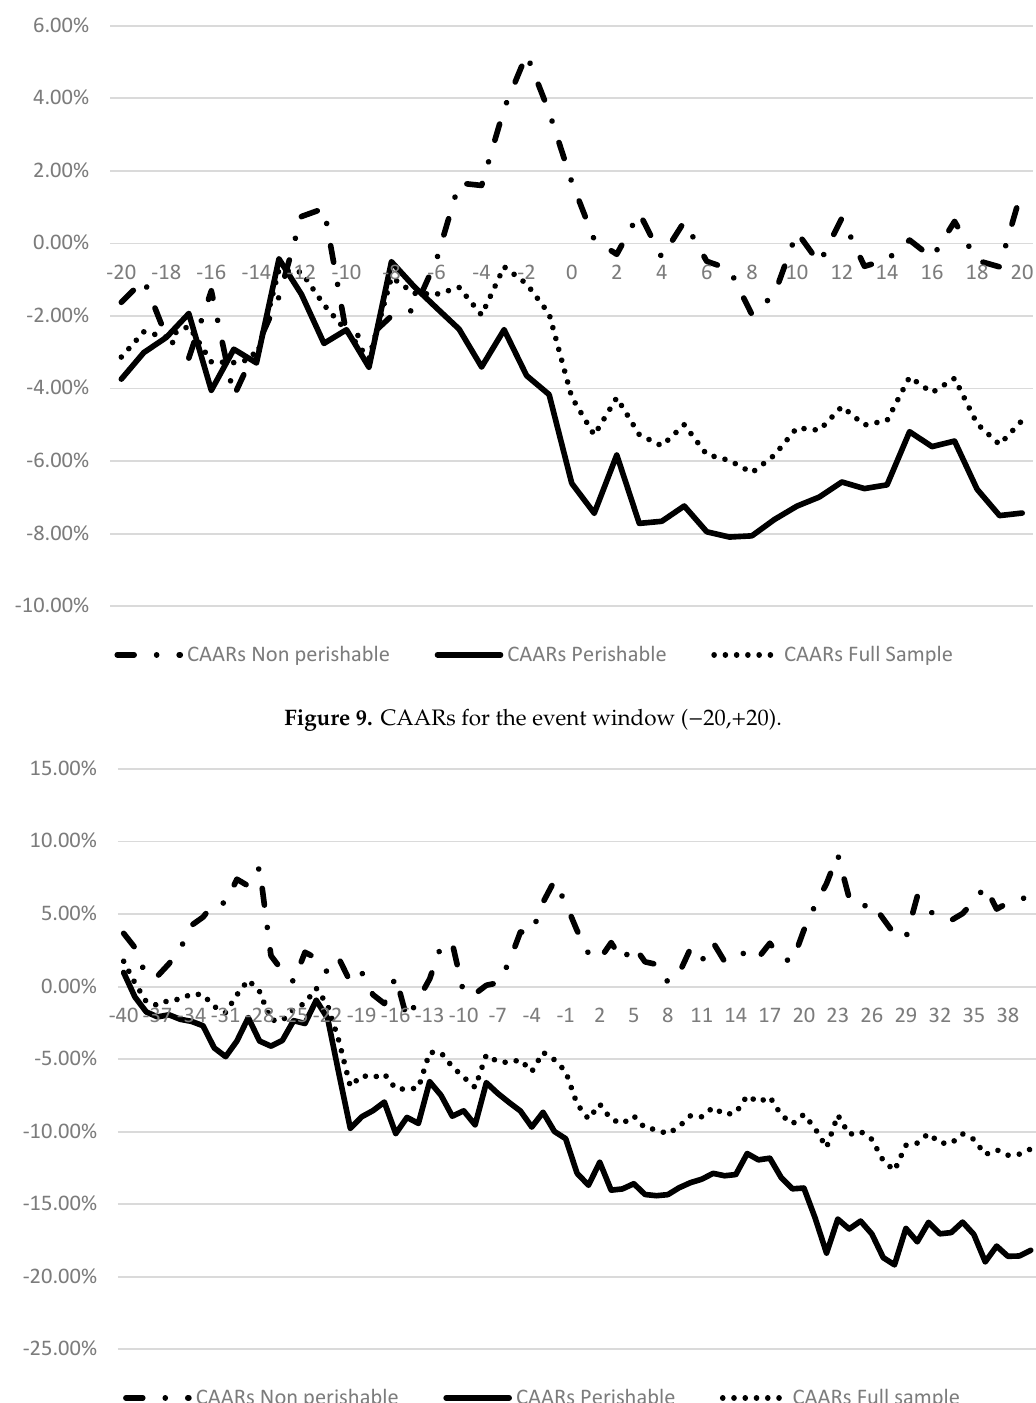
Figure 8. CAARs for the event window ( − 5,+5).